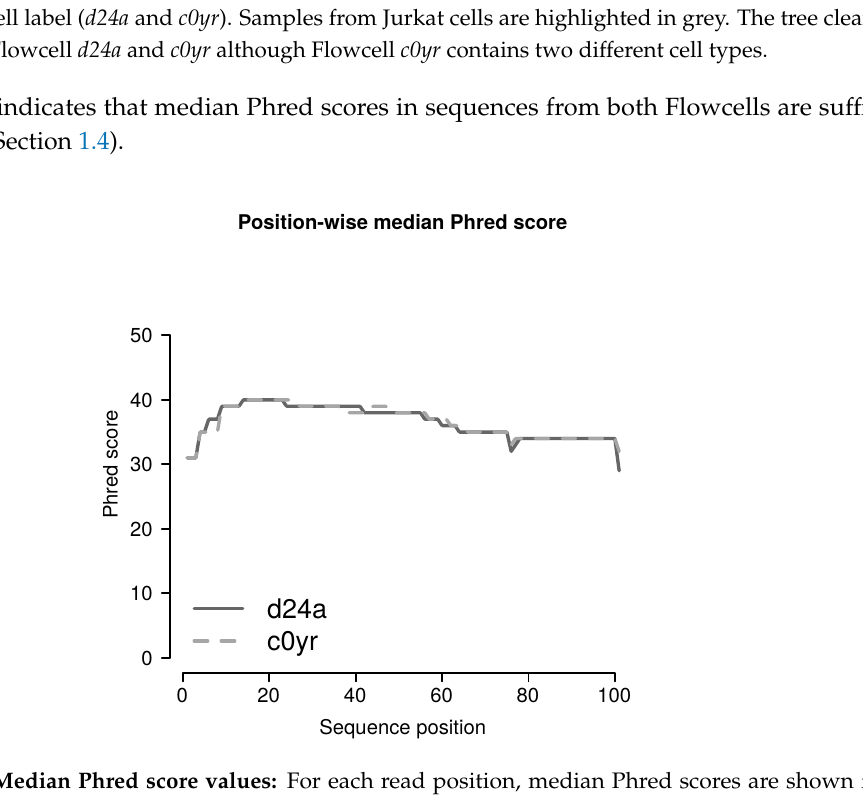
Figure 5. Median Phred score values: For each read position, median Phred scores are shown for samples sequenced on Flowcells d24a and c0yr . All median Phred scores are >